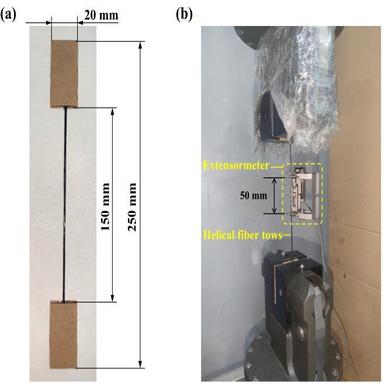
(a) Schematic diagram of specimen geometric dimension; (b) Uniaxial tensile test machine.